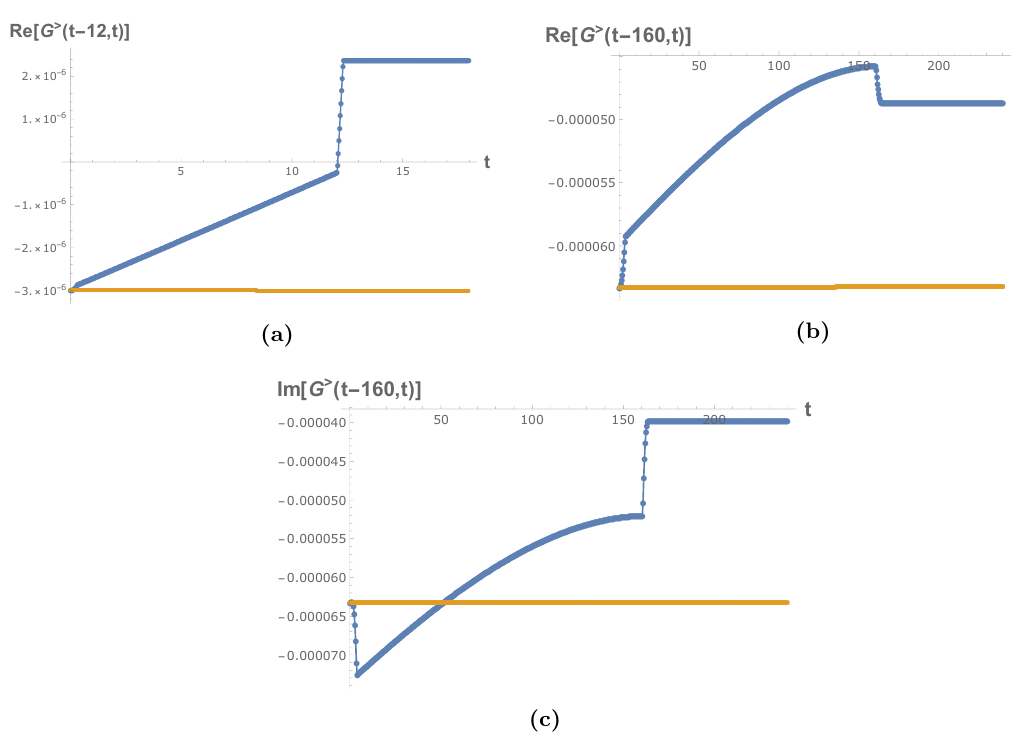
Figure 7. Time evolution of the real part of greater Green’s function G > ( t − t a , t ) as a function of t for fixed t a showing the instantaneous thermalization (blue plots): (a) case 1 starting from the dilute gas state with µ = − 0 . 27 , η = 0 and β = 30 and quantum quench using time dependent J 2 term, (b) case 2 starting from the dilute gas state with µ = 0 , η = 0 . 27 and β = 30 and quantum quench using time dependent J 2 term, and (c) case 3 starting from the dilute gas state with µ = 0 , η = 0 . 27 and β = 30 and quantum quench using time dependent J 6 term. The orange plots are equilibrium time evolutions for the respective initial states without any time dependent